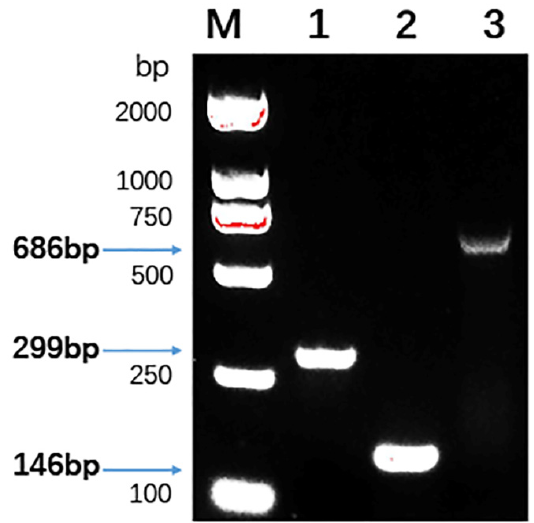
Figure 4. Agarose gel electrophoresis of the PCR products of QP28-1 bacteriocin-related genes. Lane M: DNA marker; lane 1: the product of plnS (299 bp); lane 2: the product of plnN (146 bp); and lane 3: the product of plnW (686 bp).